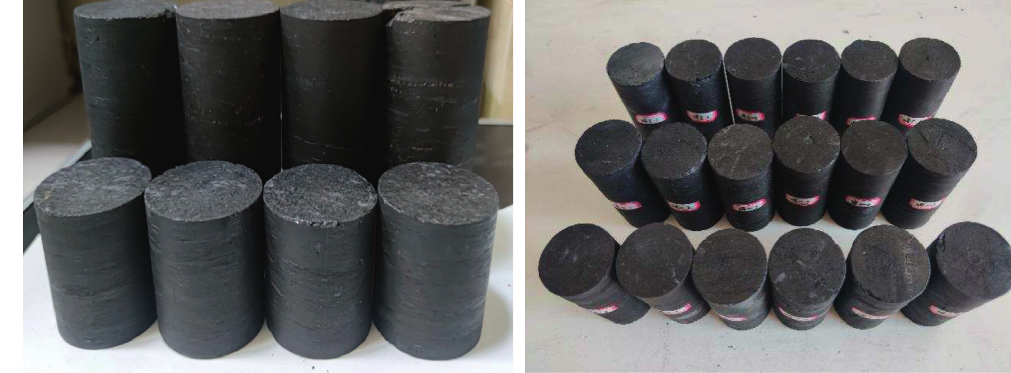
Figure 1: Coal sample specimen.